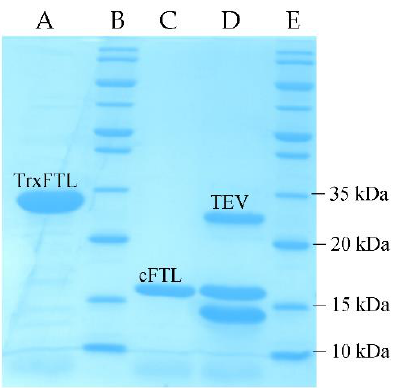
Figure 2. SDS-PAGE analysis of purification of TrxFTL and cFTL from E. coli . Lane A, FTL in fusion with TrxA (TrxFTL) purified by IMAC; Lanes B and E, molecular weight marker; Lane C, FTL cleaved and purified by reverse IMAC from TrxFTL; Lane D, products of digestion of TrxFTL with TEV protease (cFTL~17.4 kDa; TrxA~14.3 kDa).